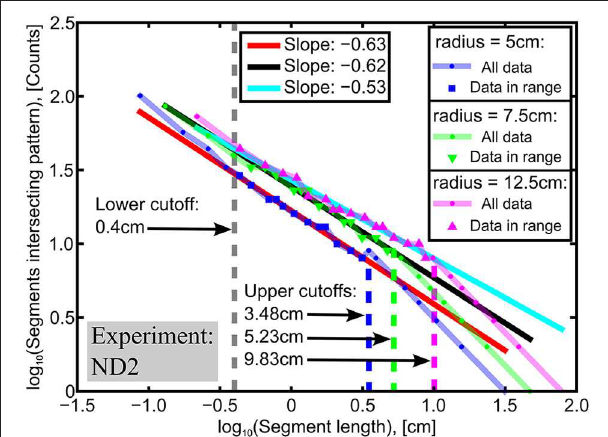
FIGURE 4 | Results of 1-dimensional box counts of the ND2 pattern along a radius of 5, 7.5, and 12.5cm. The slopes that are used to determine the local fractal dimension are fitted to the data points in the range between the lower cutoff of 0.4cm (average finger width) and the upper cutoffs where the pattern appears space filling (indicated by arrows). We see that the upper cutoff, which is approximately the separation between fingers, increase for increasing radius. Local dimension as function of radius is found as the negative value of such slopes, estimated at each pixel radius (approximately every 0.04 cm) outside the injection region. However, at radii where there are < 10 data points between cutoffs, the local dimensions are not included for